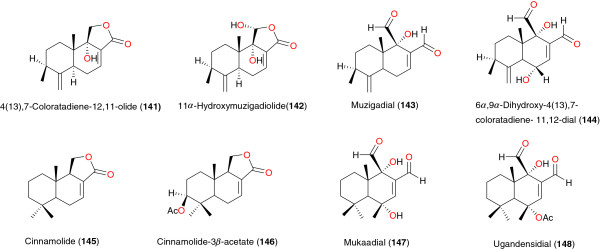
Coloratane sesquiterpenes from African medicinal plants with anti-malarial activity.